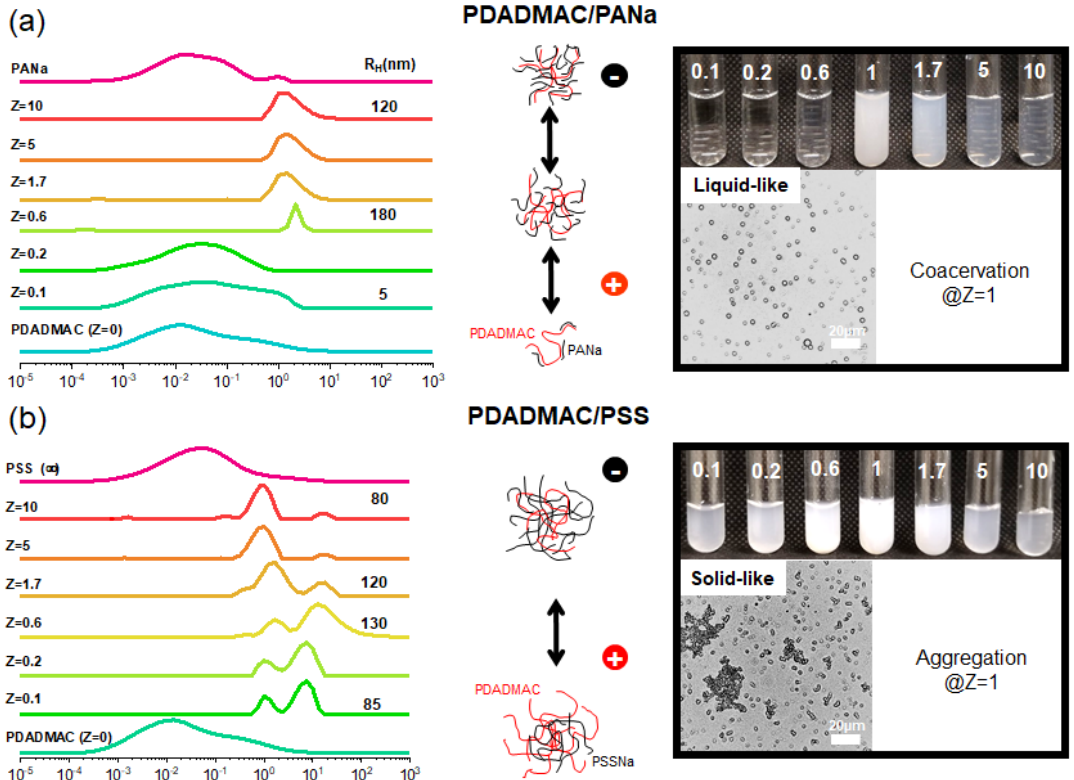
Figure 3. Spectra of the relaxation times (and hydrodynamic radii) and photographs of the PEC dispersions taken at dif- ferent Z values together with microscopic images taken at charge stoichiometry (Z = 1) of PDADMAC/PANa ( a ) and PDADMAC/PSSNa. ( b ) PECs were generated at different molar charge ratios (Z) from PE solutions prepared at 18.6 mM, pH 10 without added salt.